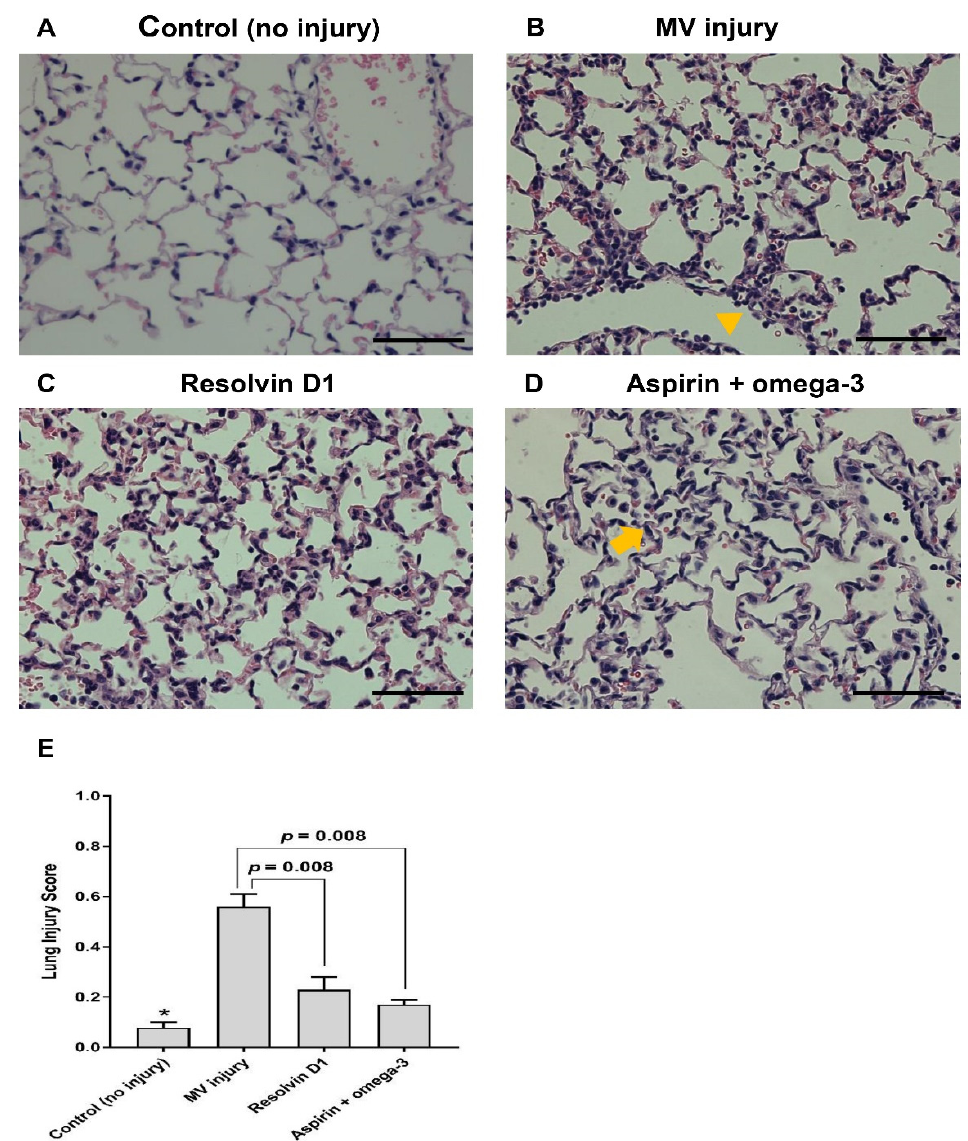
Figure 3. Representative photomicrographs of lung tissue and lung injury scores after mechanical ventilation injury. Hematoxylin and eosin staining were performed (400 × , scale bar = 100 µ m). ( A ) Control group. ( B ) Injury only group. Active inflammatory lesion including the neutrophilic infiltration was seen in the alveolar ducts (arrow). ( C ) Resolvin D1 pretreated group. ( D ) Enteral aspirin and omega-3 pretreated group. Minimal infiltration of neutrophils was seen in the alveolar walls (arrowhead). ( E ) Lung injury score. The number of mice in the control (no injury), only injury, resolvin D1 pretreated, and aspirin and omega-3 pretreated groups were 3, 7, 4, and 4, respectively. Data are presented as mean ± standard error of the mean. * p < 0.05 for value between control group and injury only